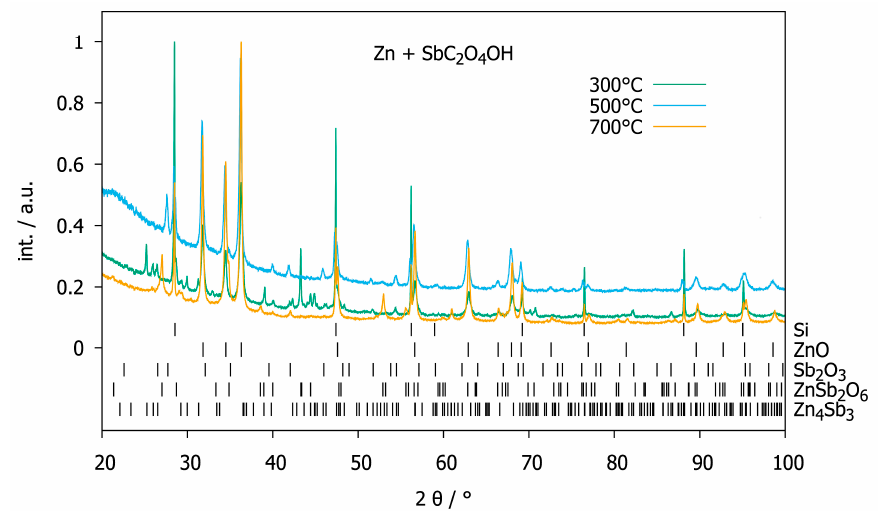
Figure 5. XRPD patterns (normalized intensities, Huber G670 diffractometer, CuK α 1 radiation, internal standard silicon powder) of a mixture of Zn and SbC 2 O 4 OH with a 10:1 molar ratio after heat treatment at 573 K (green), 773 K (blue) and 973 K (orange), respectively.